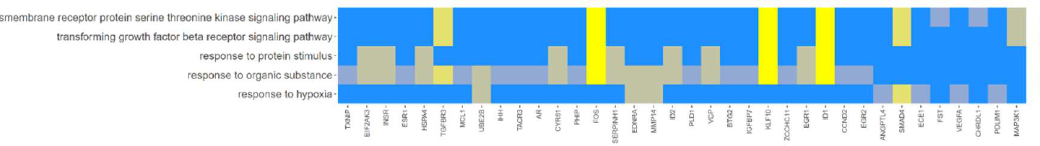
Figure 4. Heatmap showing the gene occurrence between differently expressed genes that belongs to the response to hypoxia, “response to organic substance”, “response to protein stimulus”, the “transforming growth factor β receptor signaling pathway”, and “transmembrane receptor protein serine threonine kinase signaling pathway” GO BP terms. The yellow color is associated with gene occurrence in the GO term. The intensity of the color is corresponding to amount of GO BP terms that each gene belongs to.